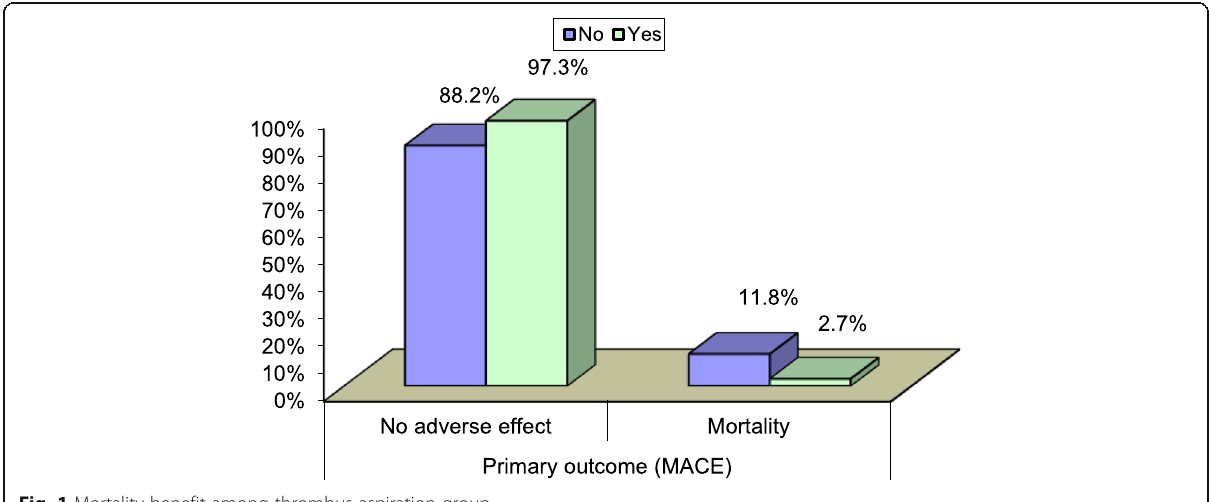
Fig. 1 Mortality benefit among thrombus aspiration group